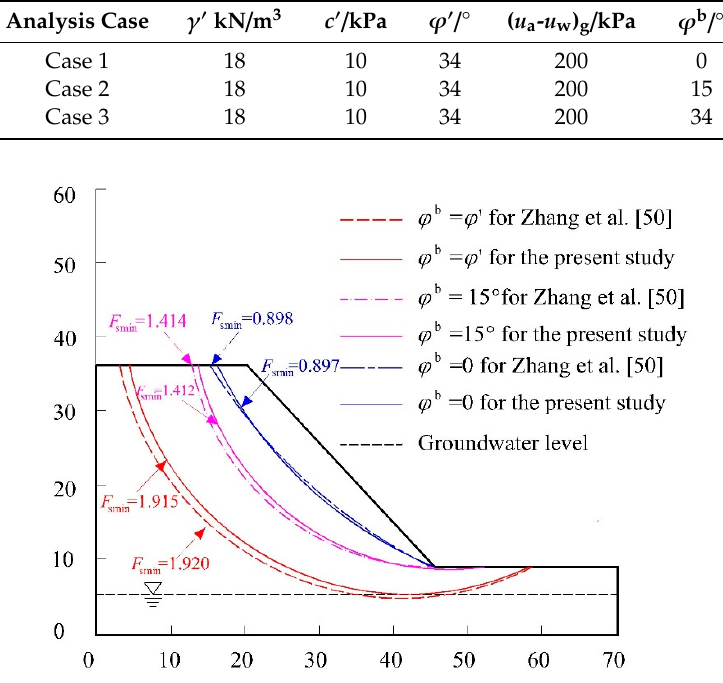
Table 2. Physic-mechanical properties of soil. Figure 8. Comparison of the critical slip surface. Figure 8. Comparison of the critical slip surface.